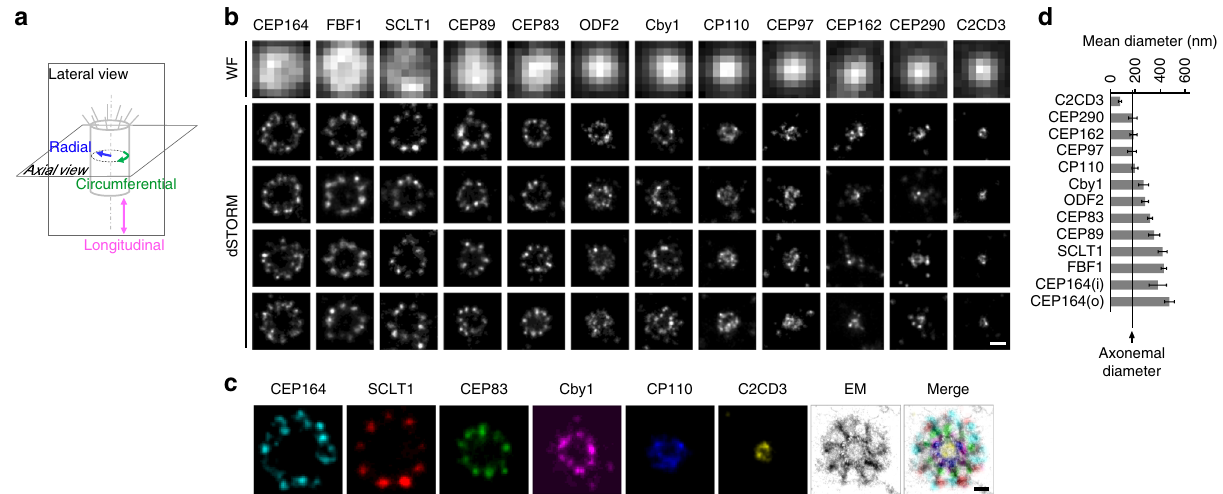
Fig. 1 Radial localization of proteins at the distal appendage (DAP) region. a De fi nitions of view angles (axial and lateral) and orientations of molecular distributions (radial, circumferential, and longitudinal) on a mother centriole. b dSTORM super-resolution images showing the distribution patterns of various DAP, sub-distal appendage, and centriolar proteins in order of radial size, which are not resolvable by wide- fi eld (WF) imaging. c Axial view EM image overlaid with single-color super-resolution images of CEP164, SCLT1, CEP83, Cby1, CP110, and C2CD3, illustrating that CP110 overlaps with axonemal microtubules, whereas SCLT1 and CEP164 are localized near the tips of highly electron-dense branches of the EM image that represent DAPs. d Mean diameter analysis revealing dimensional differences among ciliary proteins in b , where the diameters of CP110, CEP97, CEP162, and CEP290 are similar to that of the axoneme measured by EM (dashed line). CEP164 (o) and CEP164 (i) represent the outer and inner diameters of CEP164, respectively. The results (presented as mean ± SD) and the numbers of measured points are summarized in Supplementary Table 1. Bars b = 200 nm and c = 100